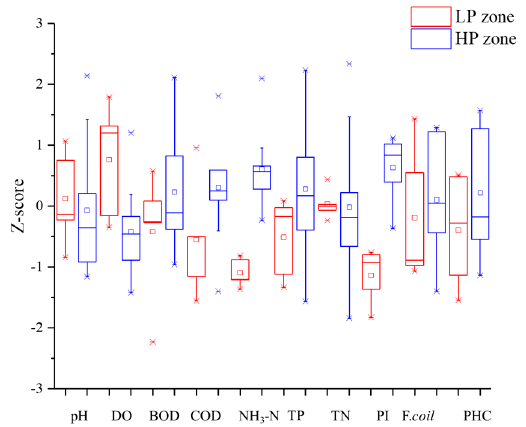
Figure 3. Spatial variation of water indictors in Dongying District.